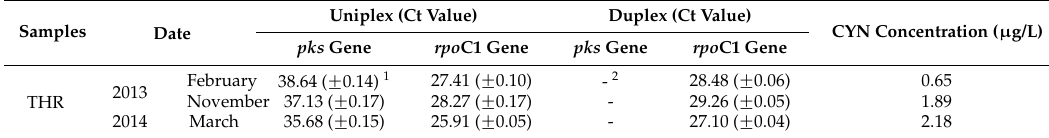
Table 1. The interference of gene detection in the duplex Cylindrospermopsis system.